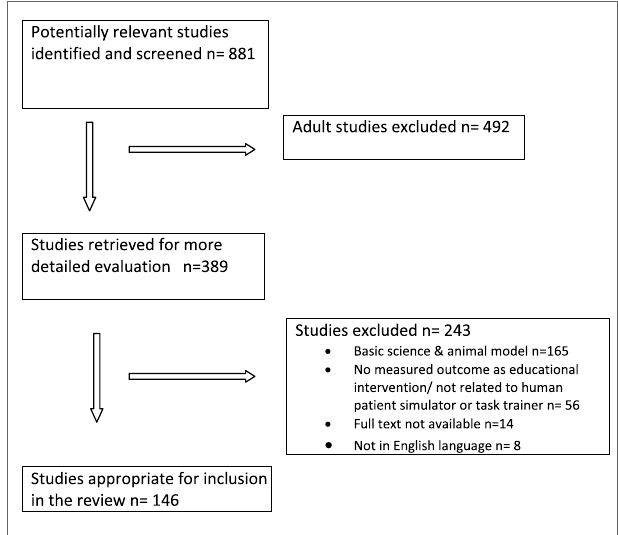
FiGURe 1 | Selection process for study inclusion